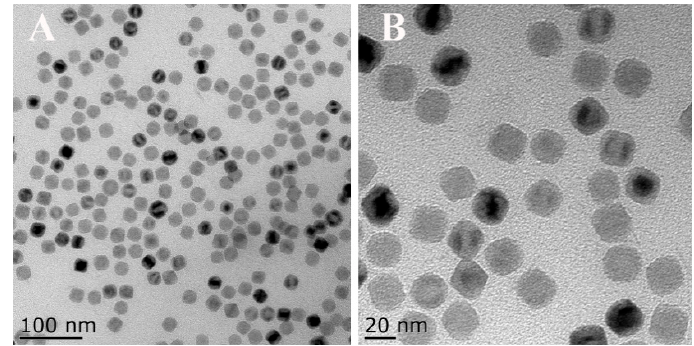
Figure 2. TEM of Fe 3 O 4 -NCs.